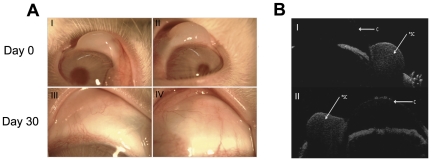
Rabbit eyes condition after subconjunctival injection.Serial slit-lamp microscopy (group A) revealed no significant increase in vascularity and inflammation of all rabbit eyes (I and II: Day 0 after subconjunctival injection; III and IV: Day 30 after subconjunctival injection). AS-OCT scans (group B) revealed no abnormal scarring, scleral or conjunctival thinning in all rabbit eyes (Photos I and II). *SC = Liposome injection site; C = Cornea.